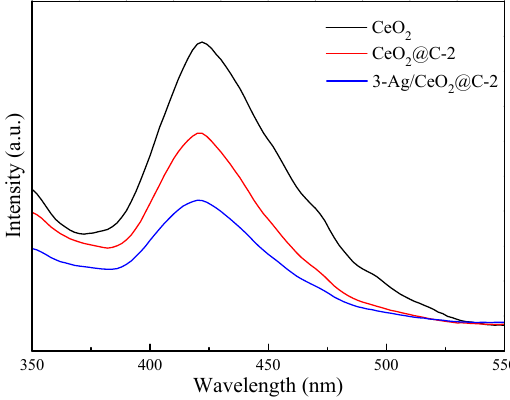
Figure 5. Photoluminescence ( PL) spectra of CeO 2 , CeO 2 @C-2, and 3-Ag/CeO 2 @C-2.